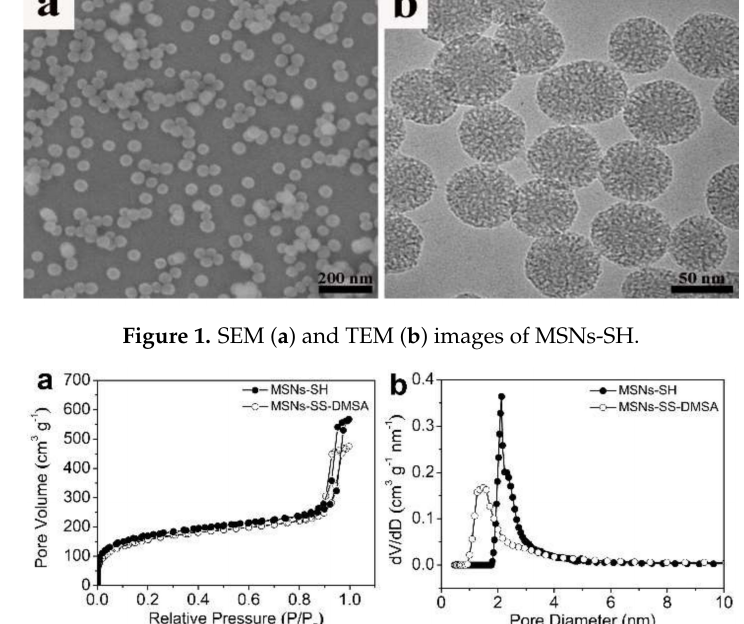
Figure 2. N 2 adsorption/desorption isotherms ( a ) and pore size ( b ) distributions of MSNs derivatives.